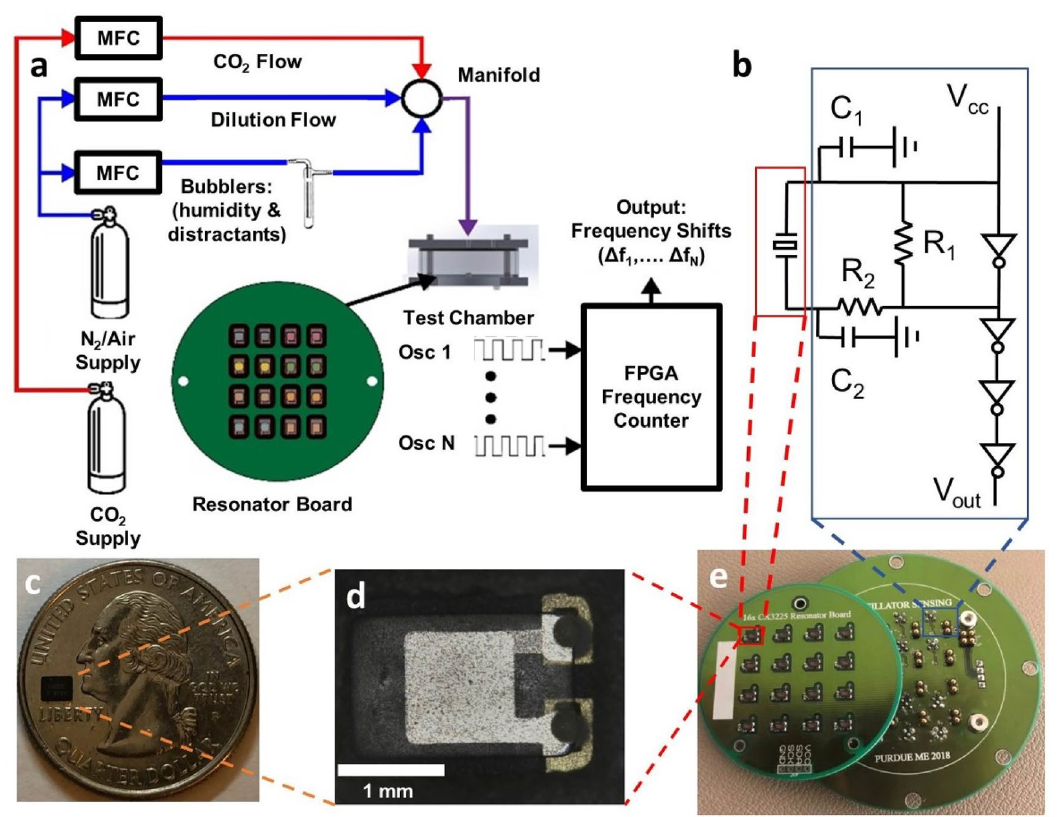
Figure 6. ( a ) Schematic of the gas distribution system used for sensor testing. Mass flow controllers (MFCs) modulated supply gases to the test chamber containing functionalized oscillators. Bubblers connected to a MFC were used to moderate distractant analytes and humidity levels inside the testing chamber. A frequency counter, executed on a MyRIO FPGA monitored the frequency of each oscillator in parallel. ( b ) A schematic of the Pierce oscillator used. The resonant element, outlined by the red box, is shown on the left of the circuit diagram. The remainder of the oscillator circuit, which is contained on the instrumentation board, is outlined by the blue box. This portion of the diagram contains two load capacitors (C 1 and C 2 ), a feedback resistor (R 1 ), and an isolation resistor (R 2 ). A series of inverters between the supply voltage (V cc ) and the output voltage (V out ) are used to square-off the oscillator output signal to facilitate frequency counting. ( c ) A single packaged resonant element shown on a US quarter for scale. ( d ) An exposed quartz crystal resonant element. ( e ) A resonant mass sensing system with 16 Pierce oscillators. A resonator board (left) containing 16 resonant elements is shown offset from the instrumentation board (right) which completes the Pierce oscillator